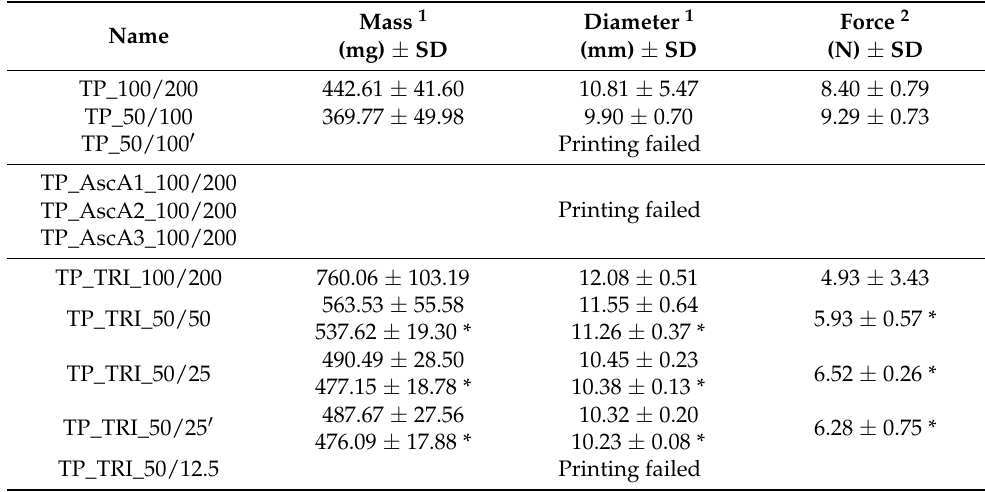
Table 6. Characteristic of placebo